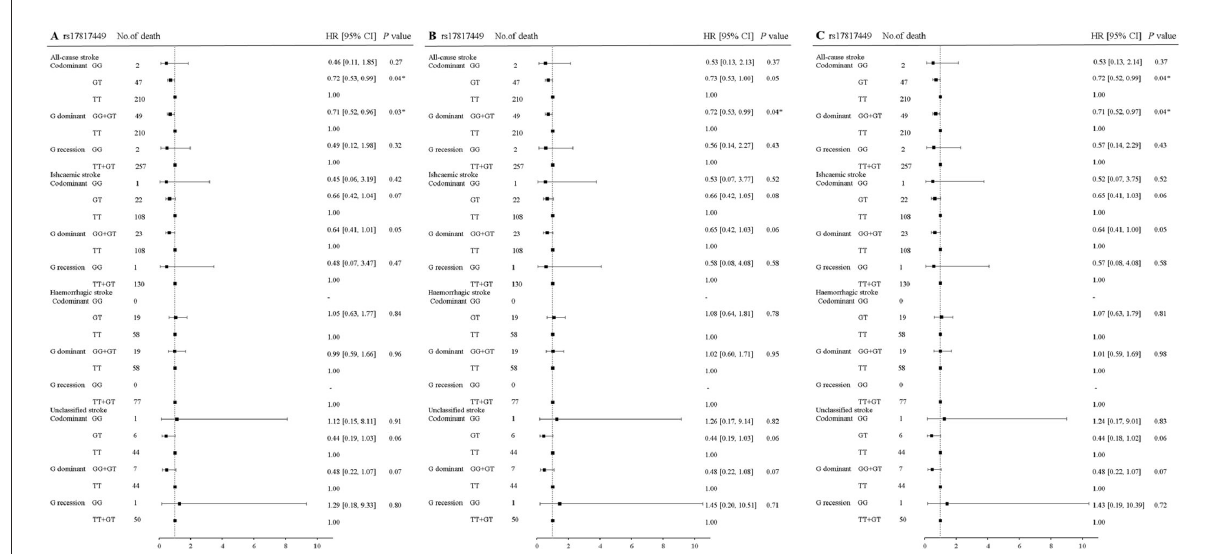
FIGURE2 Association of rs17817449 at the FTO with the risk of fatal stroke in the participants of the GBCS ( n = 13,967). (A–C) plots the hazard ratios and 95% confidence intervals for the three genotype models alongside the P -values. Model A: crude HR; Model B: adjusted for age, sex, education, job, smoking, alcohol consumption, BMI, physical activity; Model C: adjusted for age, sex, education, job, smoking, alcohol consumption, BMI, physical activity, hypertension, diabetes, and dyslipidemia. * P < 0.05.